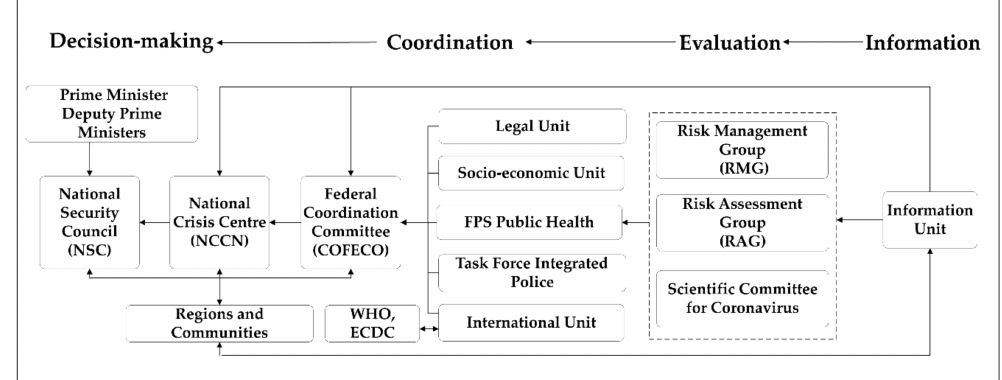
Figure 2. Public health emergency organizational structure. ECDC: European Centre for Disease prevention and Control.